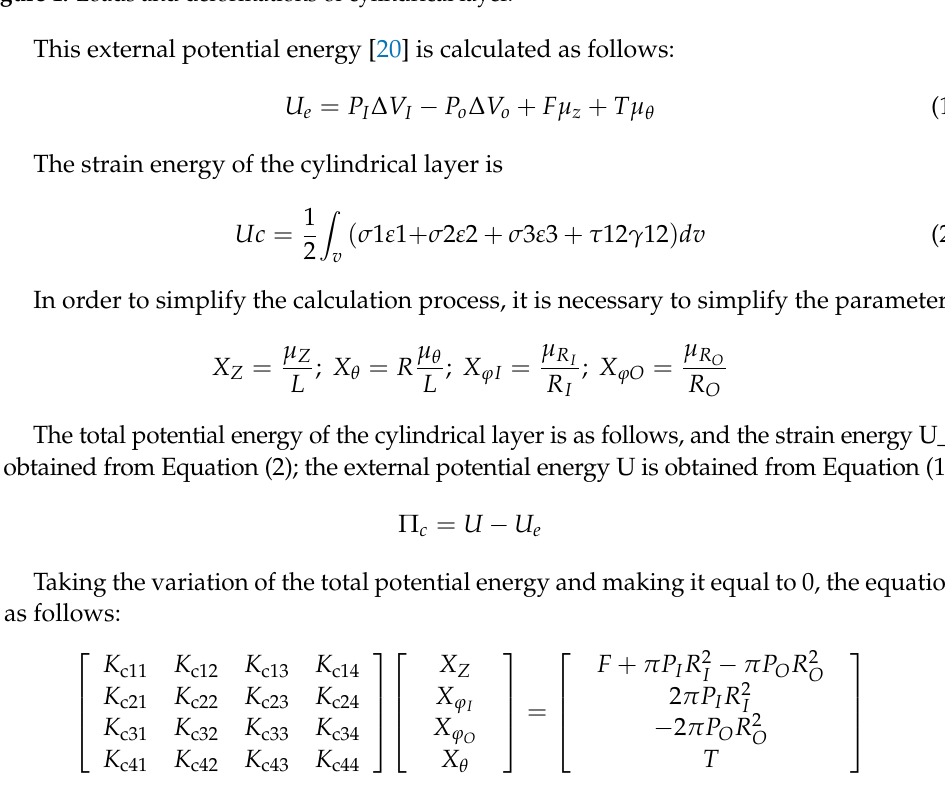
Figure 1. Loads and deformations of cylindrical layer.